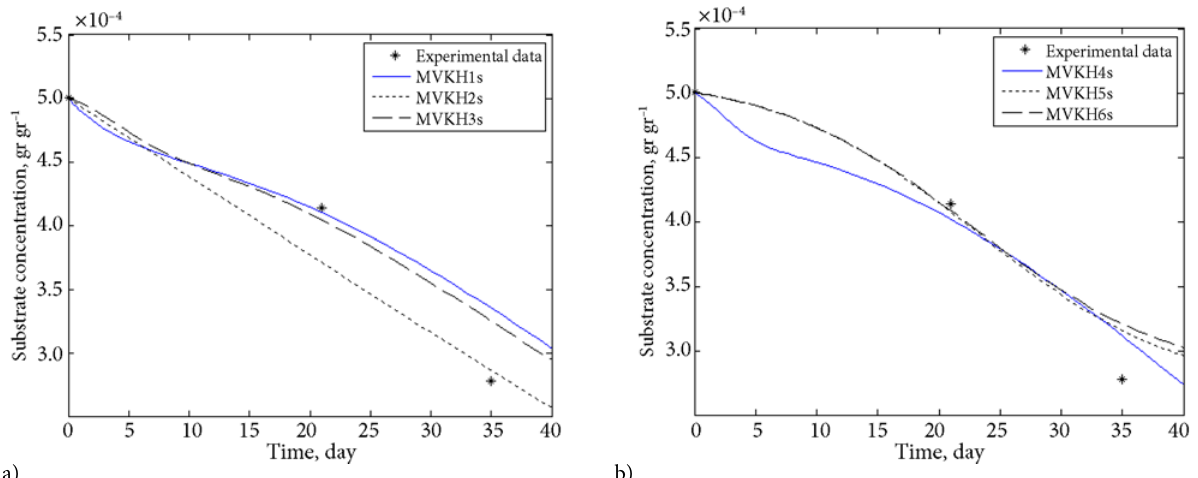
Fig. 2. a) – predictions of the contaminant variations trend versus time using MVKH1s to MVKH3s substrate consumption models accompanied with Beolchini et al. (2010) experimental data for growth of prokaryotic communities on aliphatic and polycyclic